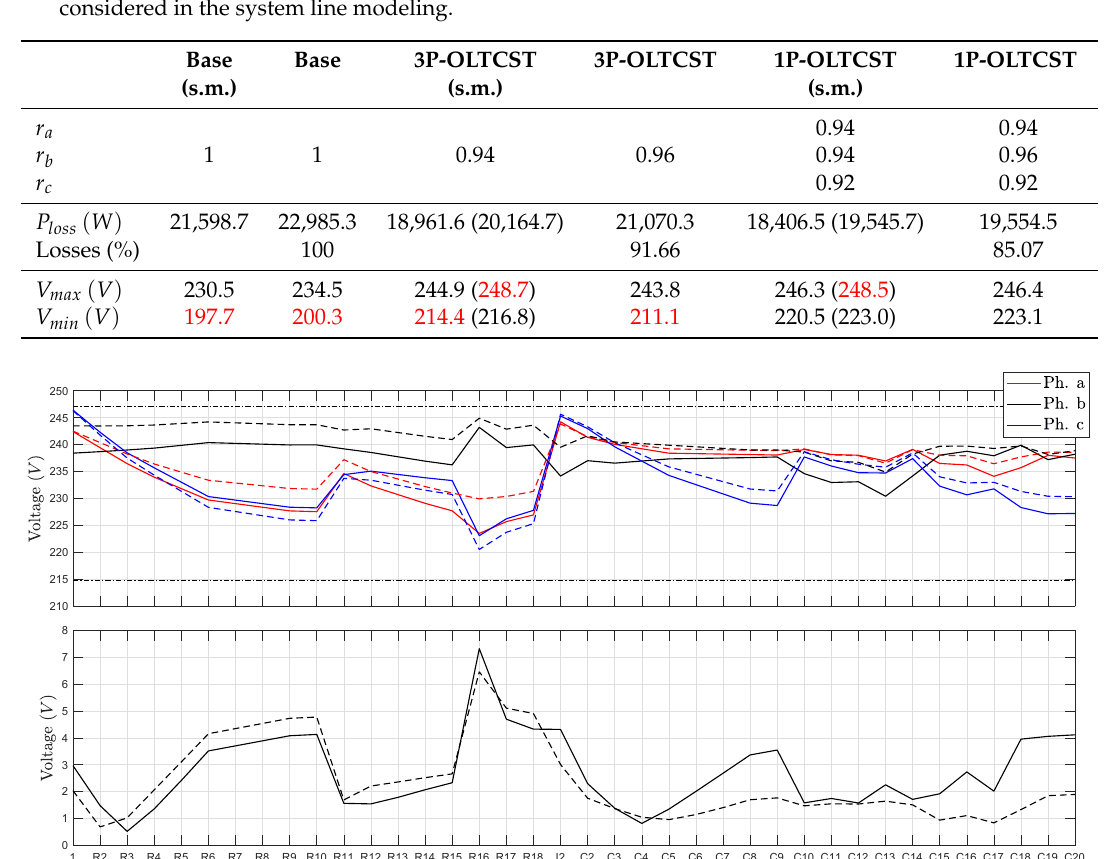
Figure 8. Simulation results when considering a 1P-OLTCST for both the accurate model and simplified model (dashed lines) of power lines.